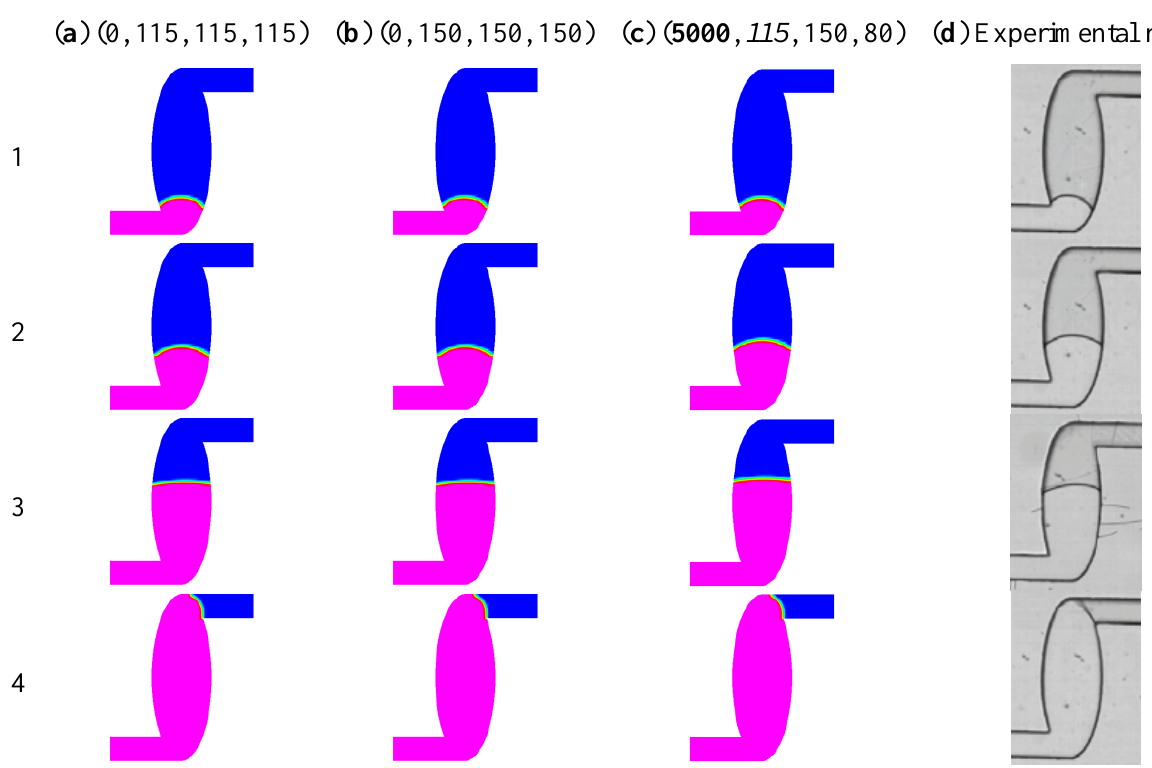
Figure 11. Computational results corresponding to experimental measurements. ( a ) K is 0° s/m, θ is 115°, θ is 115° and θ is 115°; ( b ) K is 0° s/m, θ is 150°, θ is 150° and s lc uc s lc θ is 150°; and ( c ) K is 5000° s/m, θ is 115°, θ is 80° and θ is 150°; ( d ) photographs of a uc s lc uc microchannel device showing liquid filling process.